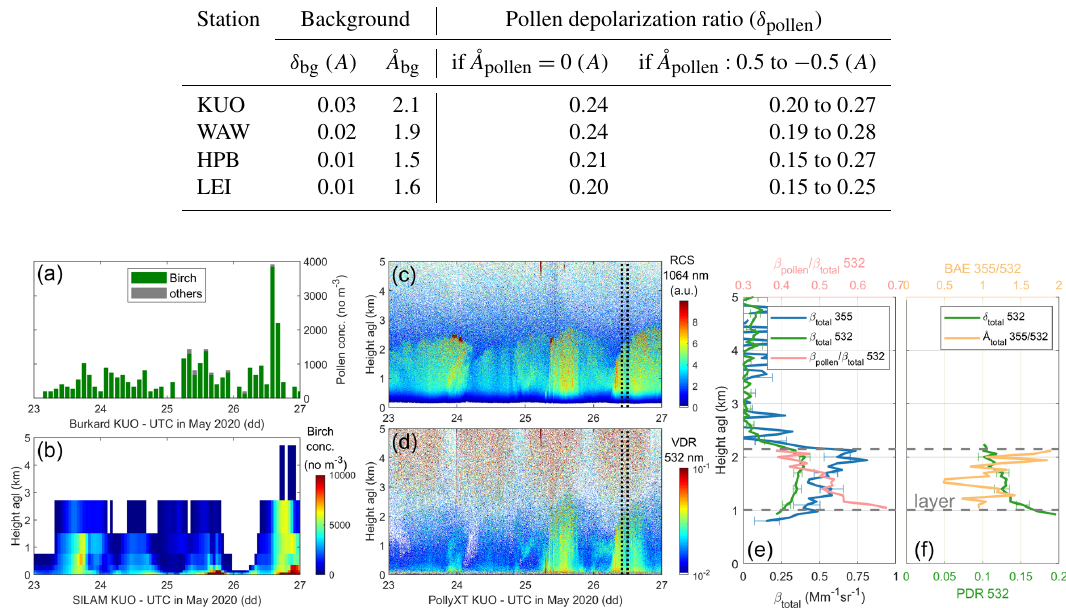
Figure 3. Overview of the pollen period and a case example at Kuopio station. (a) Pollen concentrations from the Burkard sampler at the roof level. (b) Birch pollen concentrations from the SILAM model. Time–height cross section of (c) range-corrected signal (RCS) at 1064nm and (d) volume depolarization ratio (VDR) at 532nm of Polly XT . Vertical profiles of (e) particle backscatter coefficients and the pollen backscatter contribution, (f) backscatter-related Ångström exponent (BAE) and the particle linear depolarization ratio (PDR) of the selected time period (black dotted box in c, d ). The selected pollen layer is shown between grey dashed lines in (e) and (f)